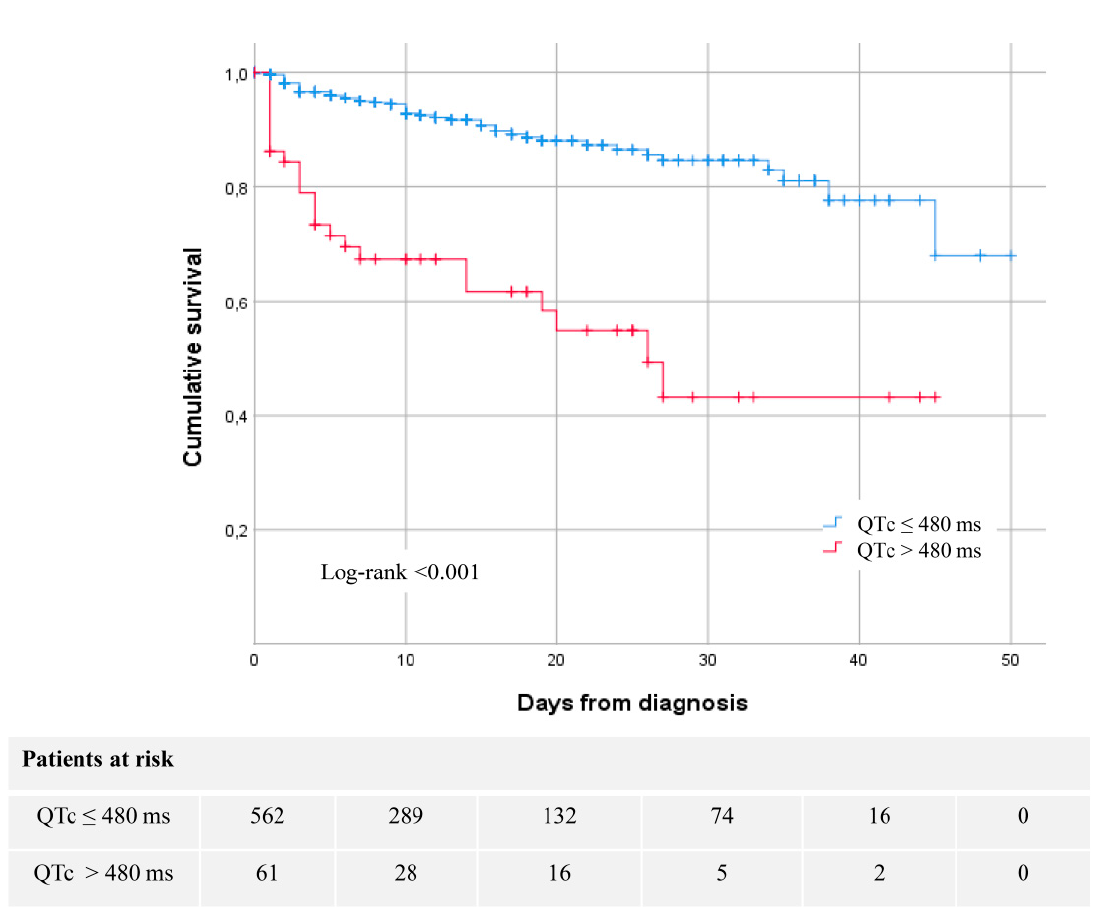
Figure 2. Kaplan–Meier 30-day survival curves for mortality by QTc during the time from medical Figure2. contact.